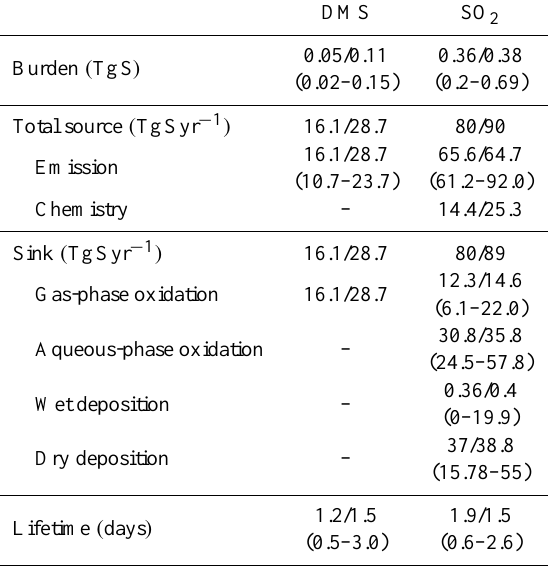
Table 3. Global budgets for DMS and SO 2 from the BASE run in ModelE2-TOMAS and ModelE2-OMA. The ModelE2-TOMAS values are presented before slashes and the ModelE2-OMA values are after slashes. Values in parentheses are ranges from other global models including Wang et al. (2011), Liu et al. (2005), and those listed in Liu et al.